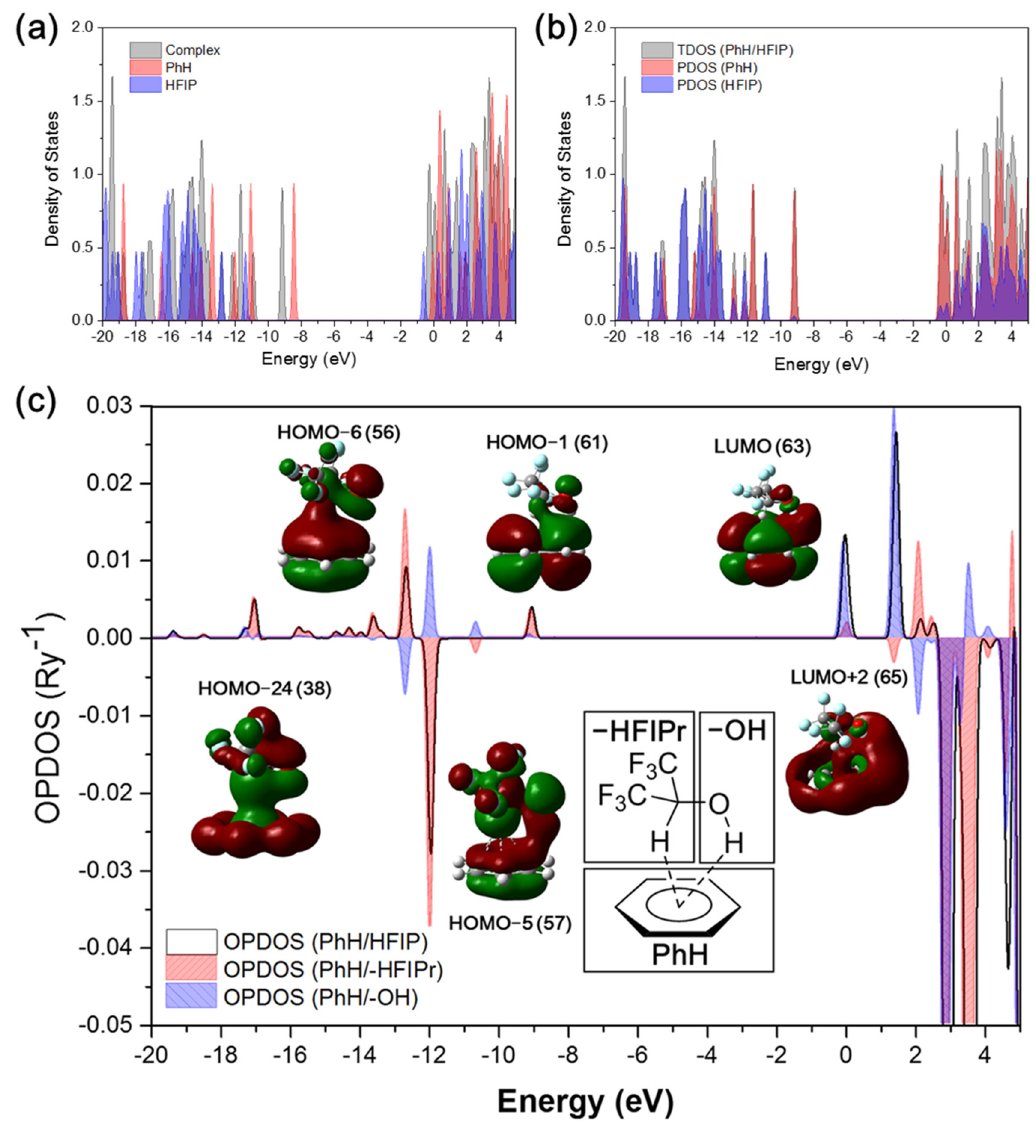
Figure 2. ( a ) The DOS of benzene (PhH), HFIP, and PhH/HFIP complex, and ( b ) the PDOS of the PhH/HFIP complex using M06-2X/6-311++G(2d,2p). ( c ) The OPDOS of the Ph/HFIP complex (black line), PhH/-HFIP (red), and PhH/-OH (blue).